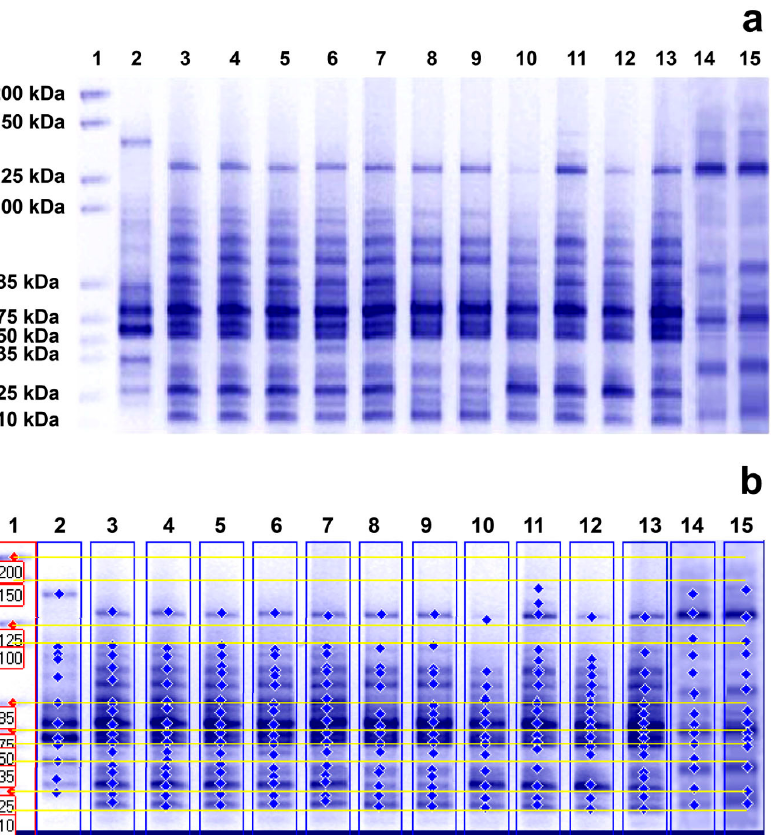
Fig. 3 . Whole cell protein fingerprinting patterns (a) and the molecular weight computerized detection of the polypeptide bands (b) generated by SDS-PAGE for 7 MRSA isolates. Lane 1 represents the protein marker; lanes 3, 5, 7, 9, 11, 13, and 15 represent the protein profiles of untreated isolates S1, S6, S7, S8, S14, S21 and S23, respectively; and lanes 2, 4, 6, 8, 10, 12, and 14 represent the protein profiles of these isolates treated with 16µg/ ml of caspofungin,